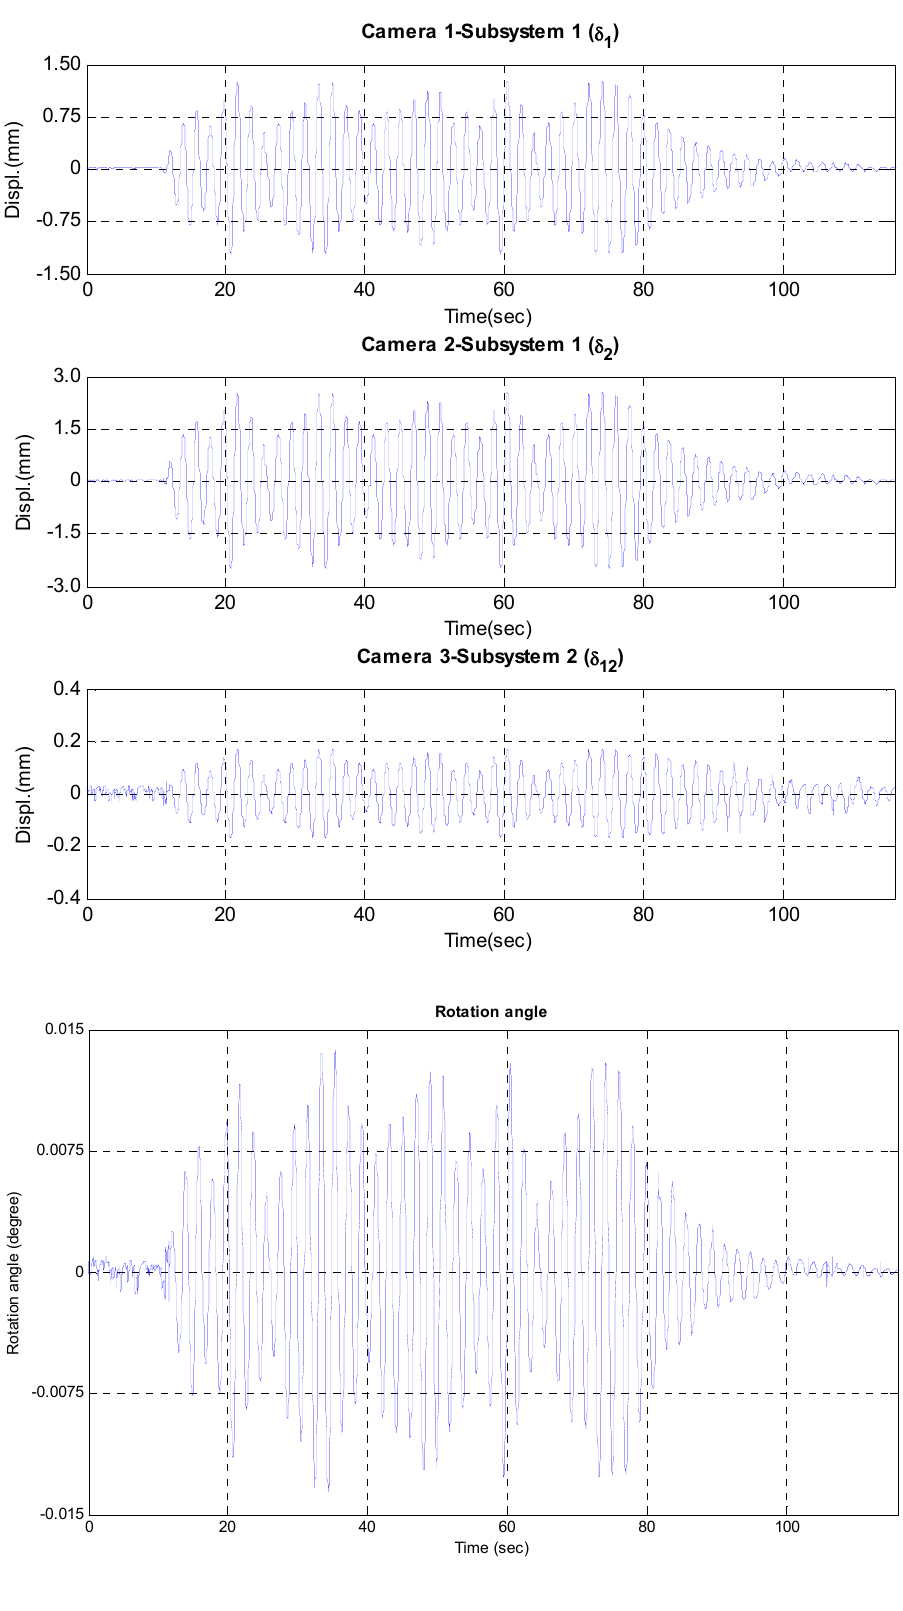
Figure 7. Measured and estimated data under random